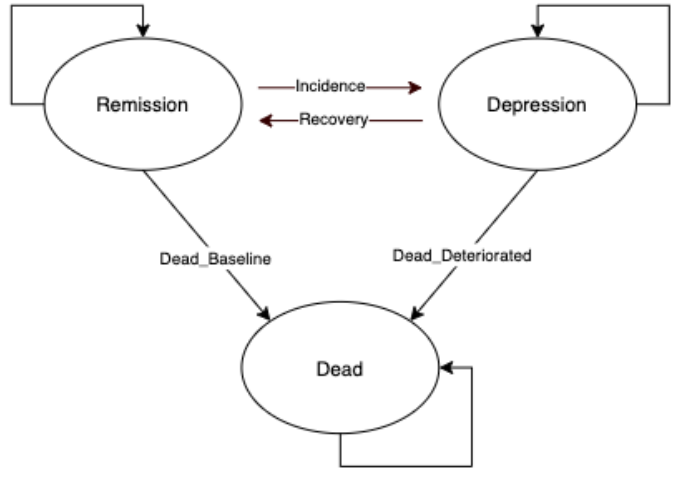
Figure 1. Diagram of the 3-state Markov model of health states and transition probabilities designed for the Super@